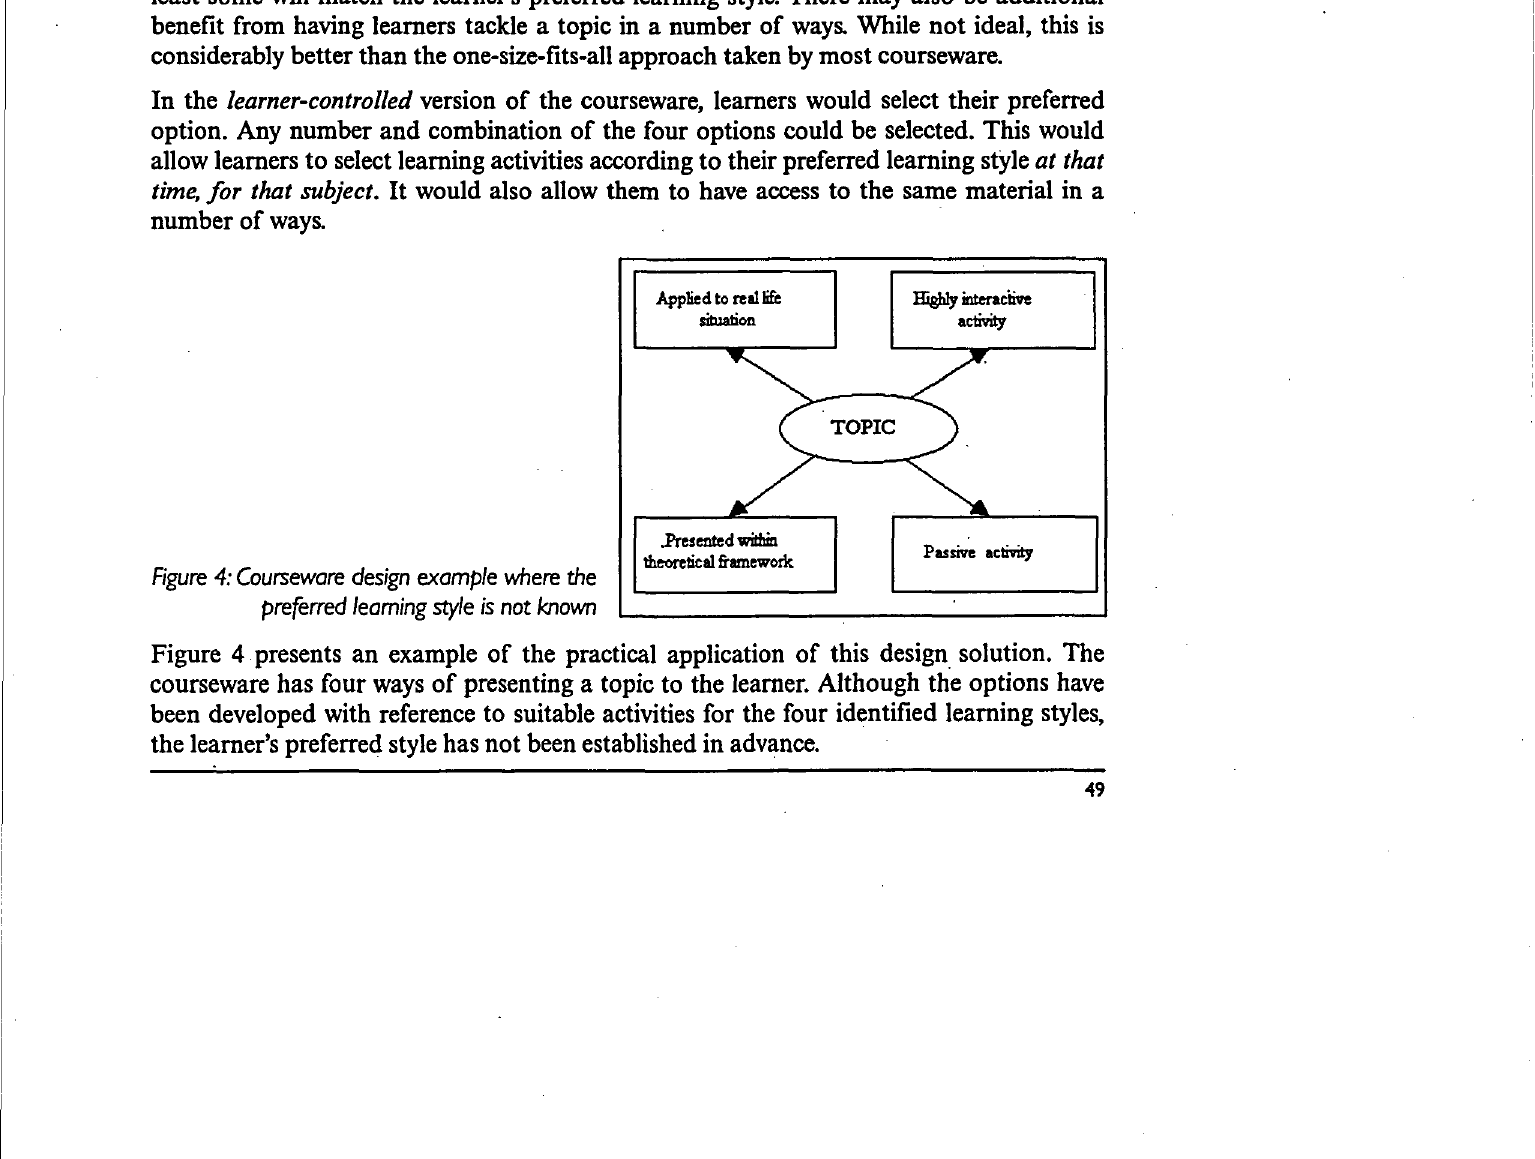
figure 4: Courseware design example where the preferred learning style is not known